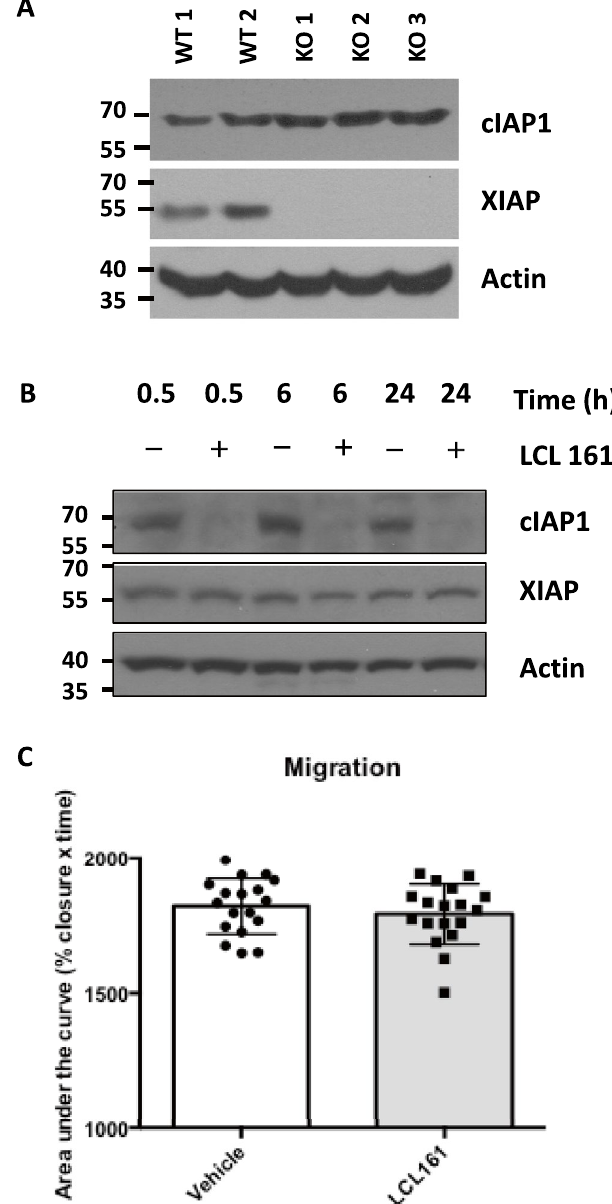
Figure 4. cIAP proteins does not significantly alter U2OS cell motility. ( A ) Whole cell lysates were prepared from CRISPR/Cas9 monoclonal U2OS cells. Lysates were subjected to immunoblot analysis to assess cIAP1 levels. ( B ) Wildtype U2OS cells were treated with the SMAC mimetic compound, LCL161, for the indicated times. Whole cell lysates were prepared and analysed by immunoblot analysis using the indicated antibodies. ( C ) Wound healing assays were performed on untreated and LCL161 treated U2OS cells and measured at 0, 8 and 24 h. The area of the wound was imaged and measured at 0, 8, and 24 h using ImageJ software. The data was normalised with the percentage wound area equalling 100% at 0 h (6 technical repeats of 3 independent experiments). The % wound area was plotted against time and the area under the curve (% wound area × time(hours)) was calculated and analysed by unpaired students